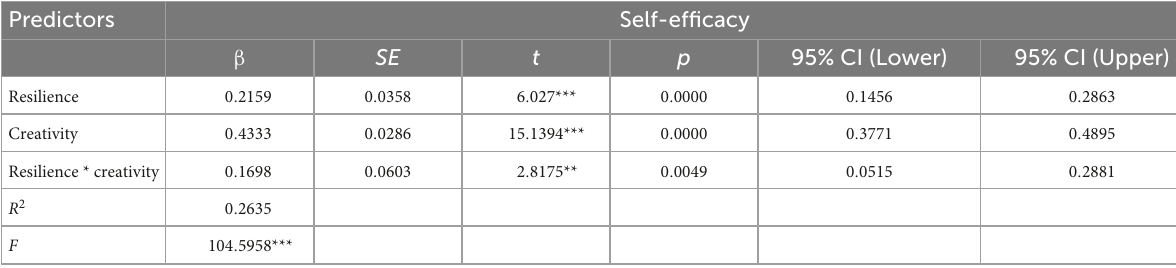
TABLE 3 Analysis of the moderating effect of creativity on self-efficacy.